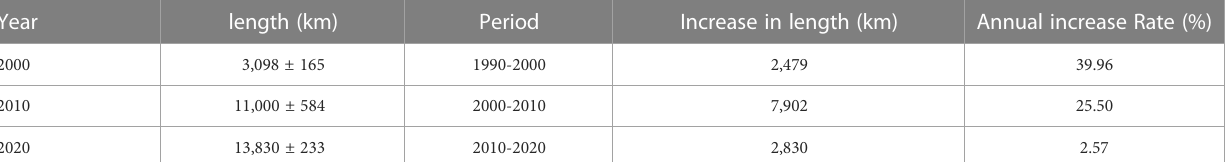
TABLE 3 Length and changes in seawalls construction over the last two decades along China ’ s coastlines.